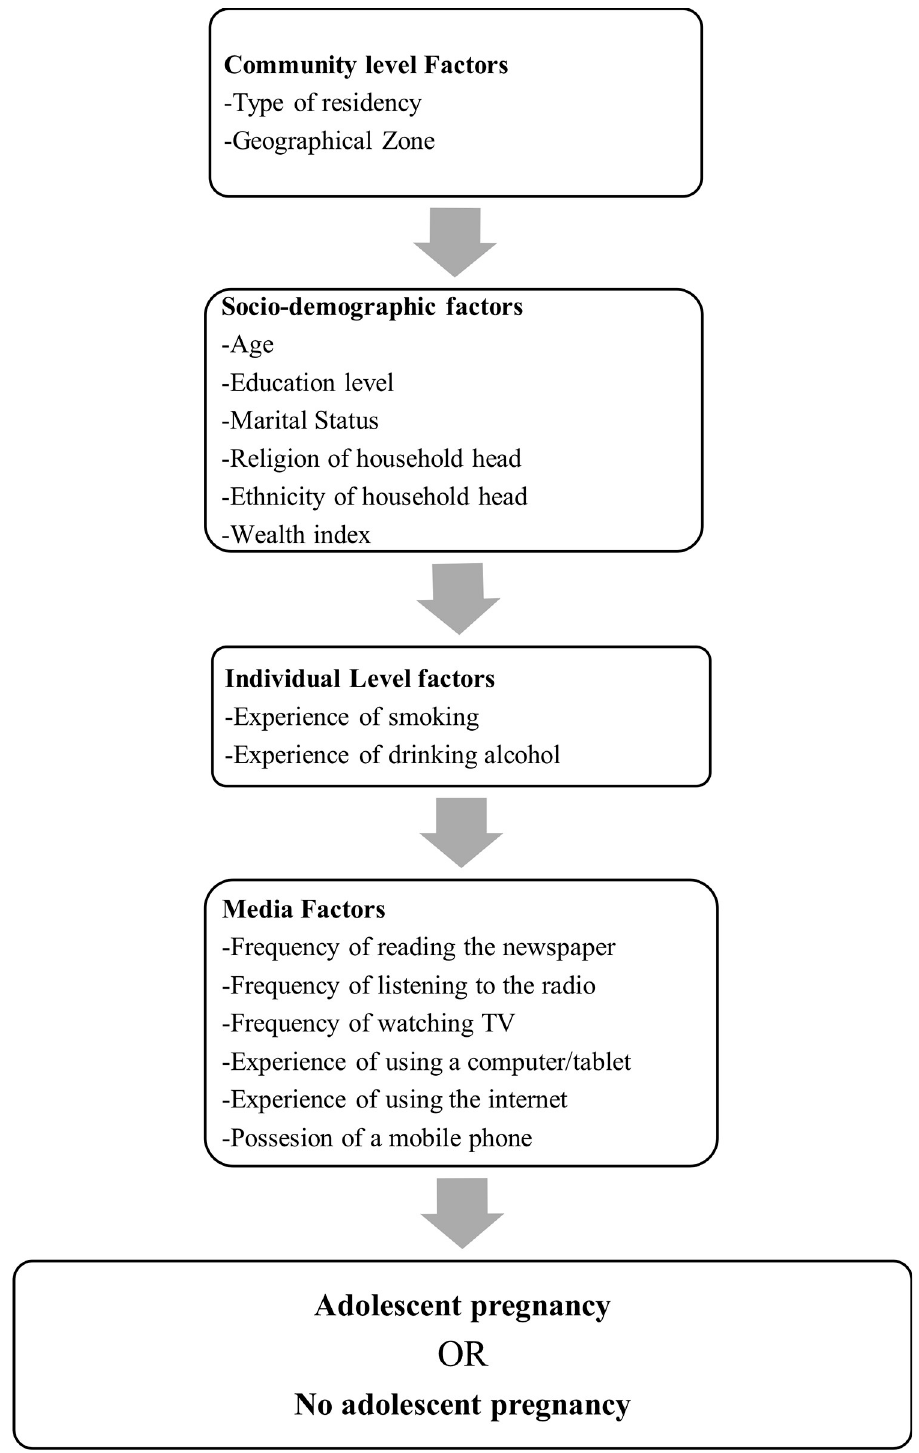
Fig 2. A modified conceptual framework for factors associated with adolescent pregnancy in